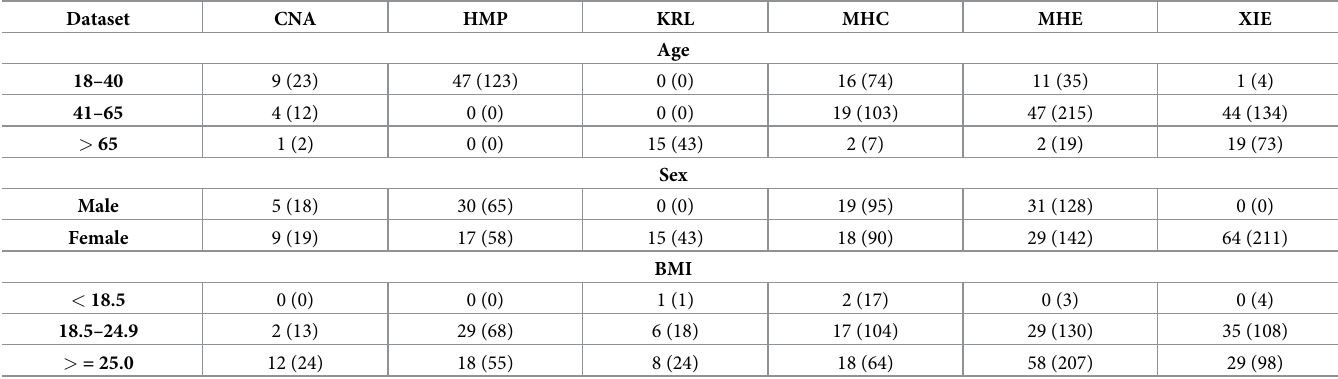
Table 3. Association of age, sex, and BMI of individuals with prevalence of